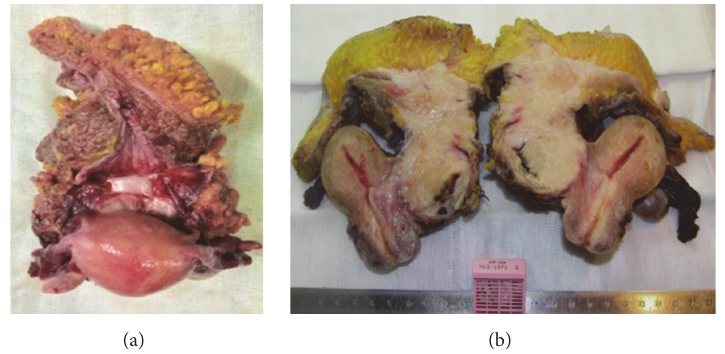
Figure 2: Macroscopic aspects: (a) superior view; (b) sagittal section.